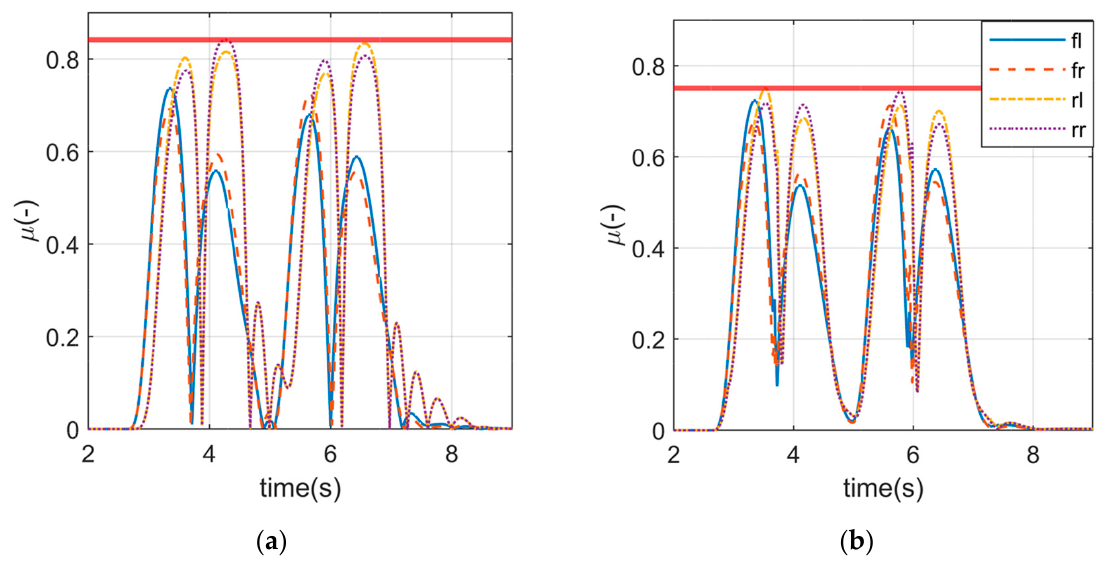
Figure 17. Tire workloads for ISO 3888-1 at 80 km/h: ( a ) Passive; ( b ) Handling mode.